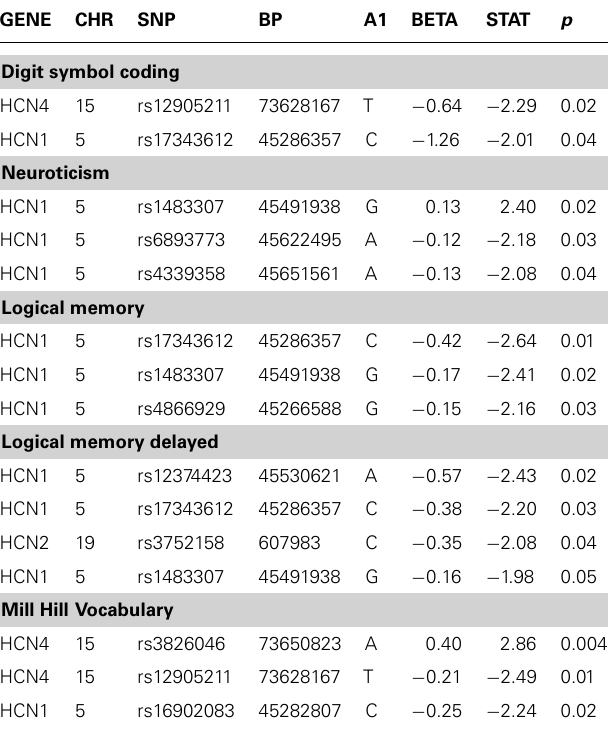
Table 4 |Association of HCN1–4 with cognition, neuroticism or extraversion where unadjusted p -value < 0.05. GENE CHR